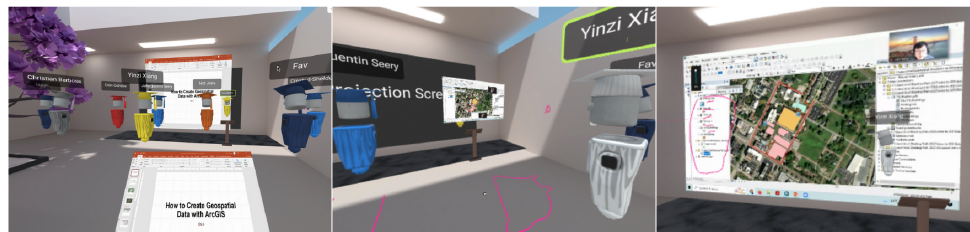
Figure 1. A selection of the virtual classroom experience. ( a ) Left is the first-person perspective of a student with the slides in front of the view. ( b ) The middle is when students are sharing screens and discussing. ( c ) The right is when students use the pink drawing tool to interact with the